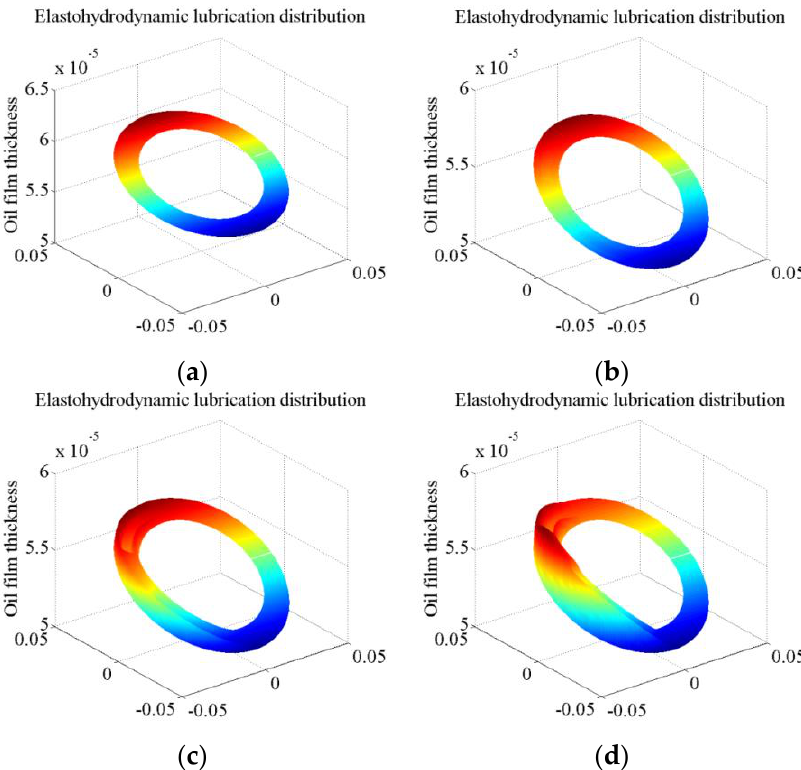
Figure 14. Effect of the viscosity on the oil film clearance under elastic deformation. ( a ) η = 0.02 pa·s; ( b ) η = 0.04 pa·s; ( c ) η = 0.06 pa·s; ( d ) η = 0.08 pa·s.